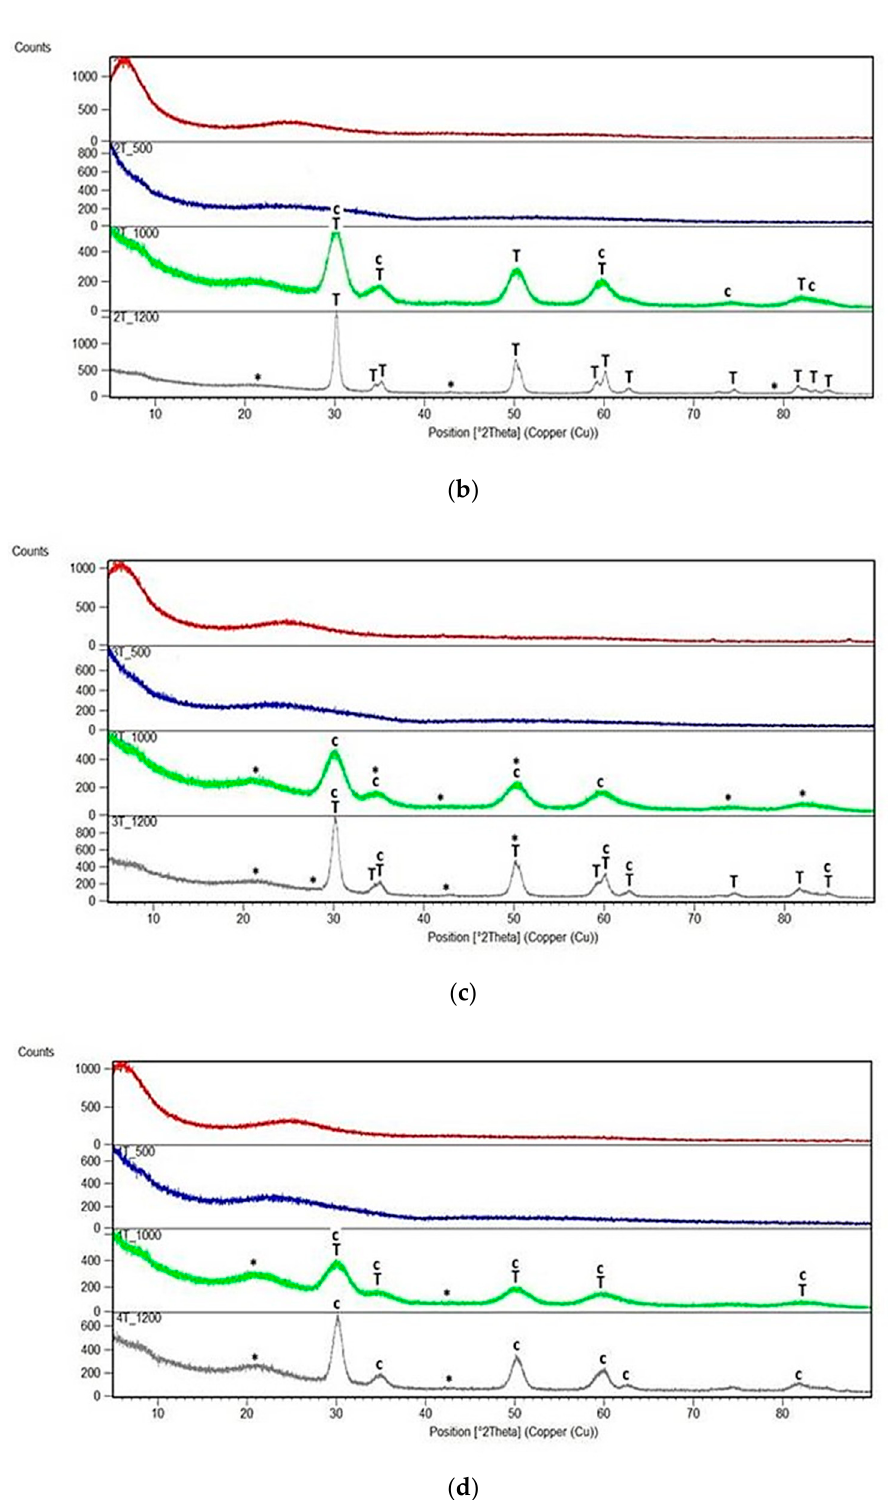
Figure 2. X-Ray diffraction patterns of: ( a ) 1T sample; ( b ) 2T sample; ( c ) 3T sample and ( d ) 4T sample. All samples were synthesized using zirconium (IV) n-propoxide and annealed at 500 °C, 1000 °C and 1200 °C in the air (*—undefined silica, T—tetragonal ZrO 2 , c—cubic ZrO 2 ). For comparison, diffraction patterns of rich in silica samples 3T and 4T pointed to the presence of the same phases t-ZrO 2 and c-ZrO 2 at 1000 °C as in the case of samples 1T and 2T but at 1200 °C both phases were present only in sample 3T together with a very small